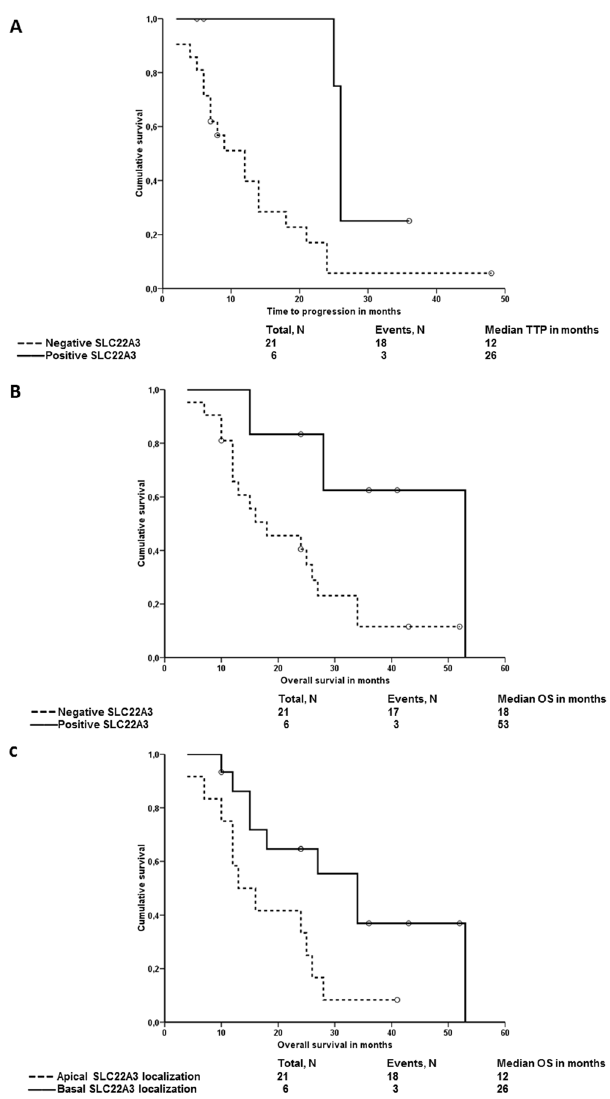
Figure 4. Associations of SLC22A3 brush border staining and localization with the survival of chemotherapy- treated patients. Kaplan-Meier survival curves were plotted for the PFS or the OS of patients divided into negative and positive or apical and basal localization groups. Dashed line represents the group with negative staining, solid line the group with positive staining. Plot A shows results of PFS analysis and plot ( B ) of OS analysis. In the plot ( C ), the solid line represents the group with basal localization and dashed line the group with apical localization of SLC22A3 protein in plasma membrane compared with OS of